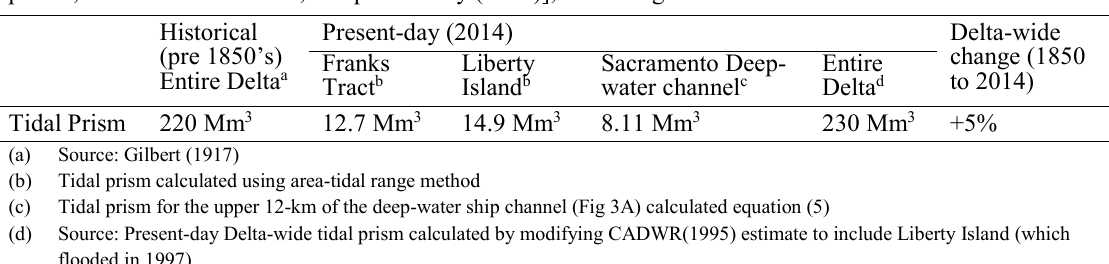
Table 1 Summary calculations of open water area, marsh surface, and tidal prism for the Delta [historical period, three areas of interest, and present day (2014)], and change from historical to 2014.